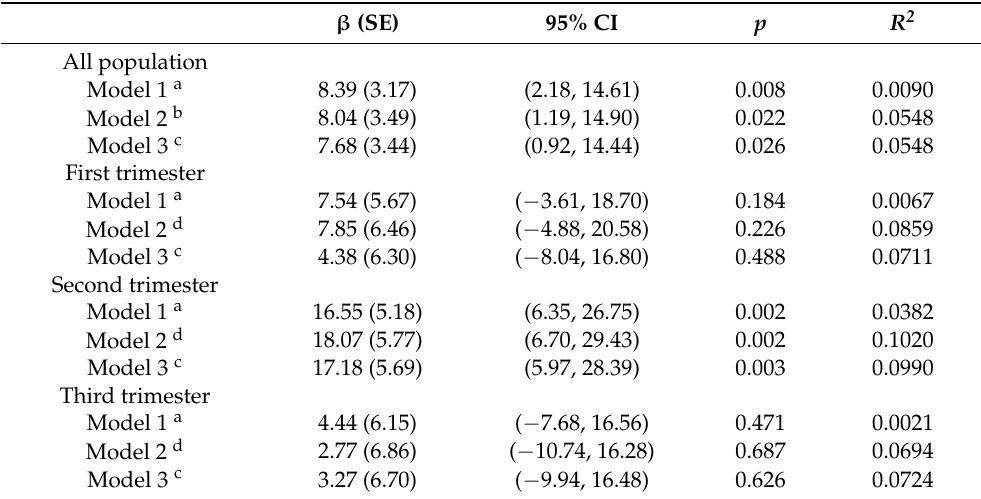
Table 5. Linear regression analysis of the association between the dietary diversity score (DDS) and the speed of sound